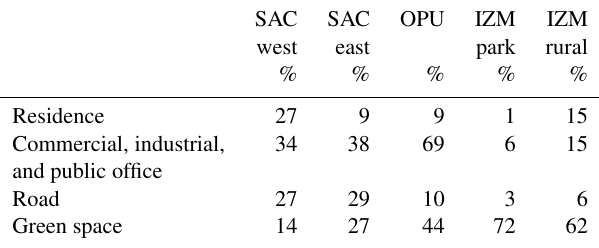
Table 1. Land cover fraction within the daytime flux footprint. Land cover classification was conducted using the Digital Map 5000 for the Kinki region in 2008 by the Geospatial Information Authority of Japan, and the green space fraction was based on a green census by the government of Sakai City. Because the land cover classifi- cation and green space are different data sources, the sum of each fraction often exceeds 100%. The daytime flux footprint was calcu- lated using the analytical footprint model (Kormann and Meixner, 2000), and median values in 2015 were classified for 16 directions (Fig.